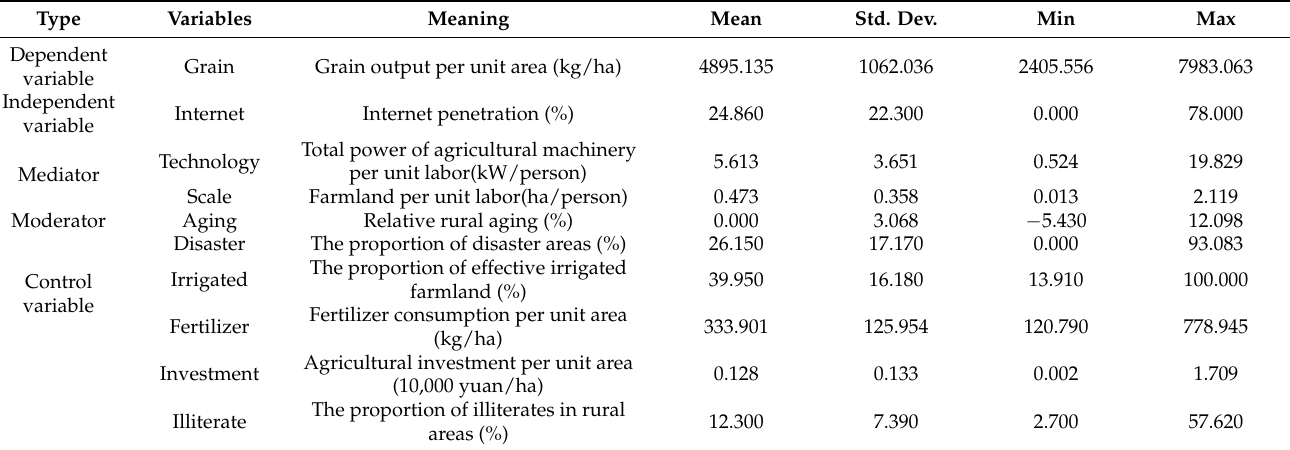
Table 1. Variables and descriptive statistics.